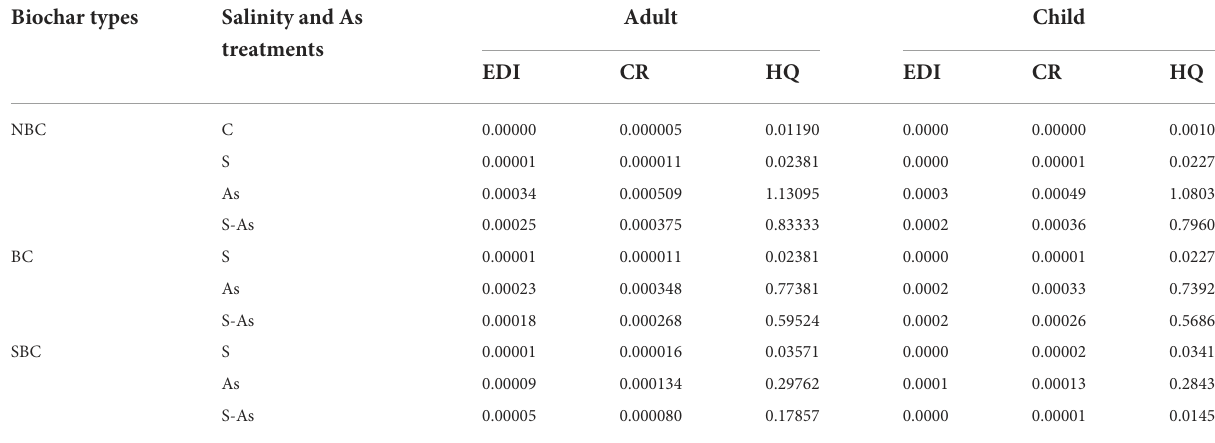
TABLE 4 Effect of salinity, arsenic, and their combination on health risk attributes of quinoa supplemented with no biochar (NBC), biochar (BC), and silicon-nanoparticles doped biochar